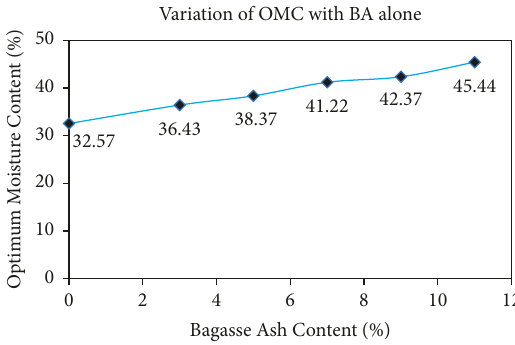
Figure 11: Effect of BA on OMC.